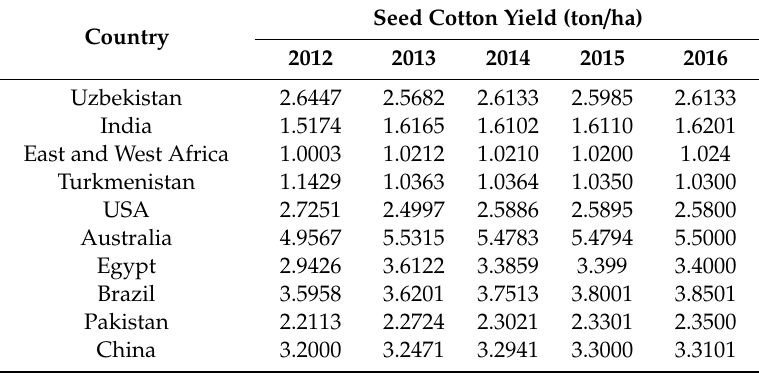
Table A5. Seed cotton yield for di ff erent cotton importing countries